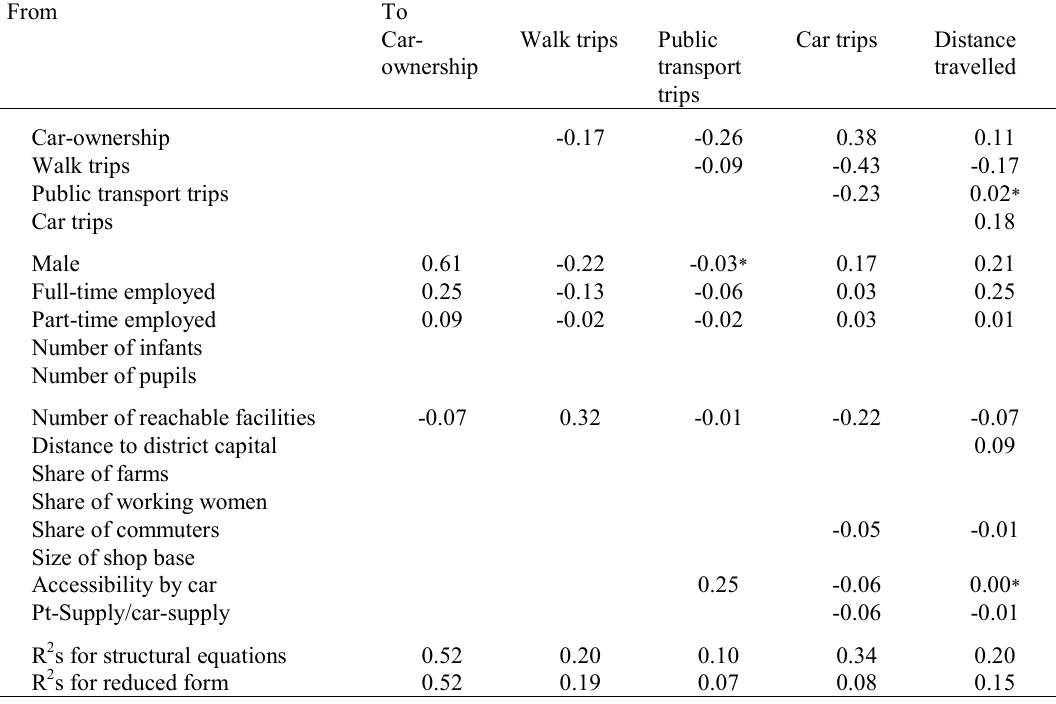
Table7. Total effects of the shopping model æ significant at the 0.001